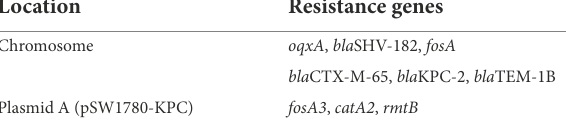
TABLE 1 Klebsiella pneumoniae SW1780 antibiotic resistance